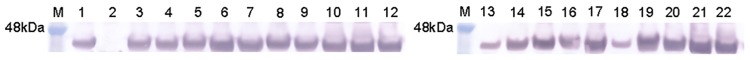
Antiserum raised against peptide 7 is cross-reactive with AniA from a range of N. gonorrhoeae clinical isolates.Antiserum from the rabbit immunized with peptide 7 was analysed by western blotting against cell lysates from a range of N. gonorrhoeae clinical isolates (Table 1) at a dilution of 1: 5000. M = molecular weight marker, 1: 1291, 2: 1291 aniA::kan, 3: 02G0142, 4: 90/G747, 5: 98G1131, 6: 88G285, 7: 02D004, 8: 02D156, 9: 02W001, 10: 02W006, 11: 98D159, 12: 97D040, 13: 01D1052, 14: 01G1370, 15: 02G0427, 16: 02G1036, 17: 94G163, 18: 00G0794, 19: 01D064, 20: 01D100, 21: 97D059, 22: 96D551.